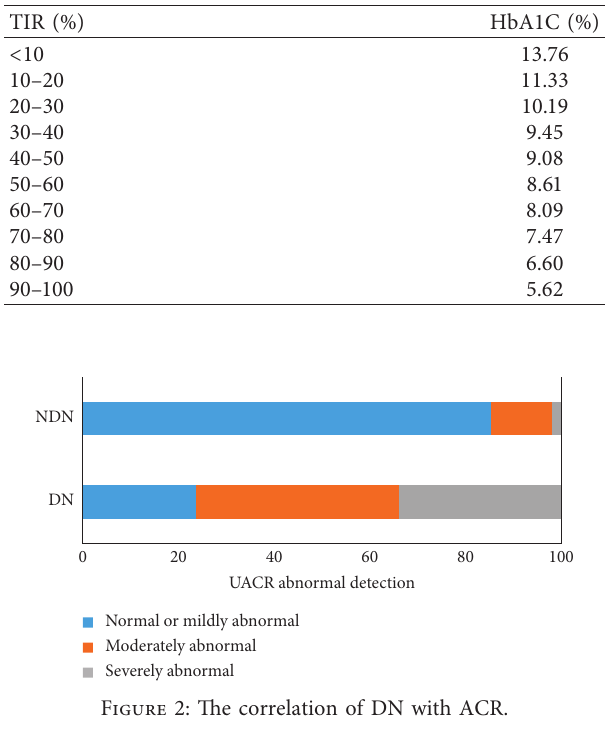
Table 2: HbA1c corresponding to every 10% TIR.